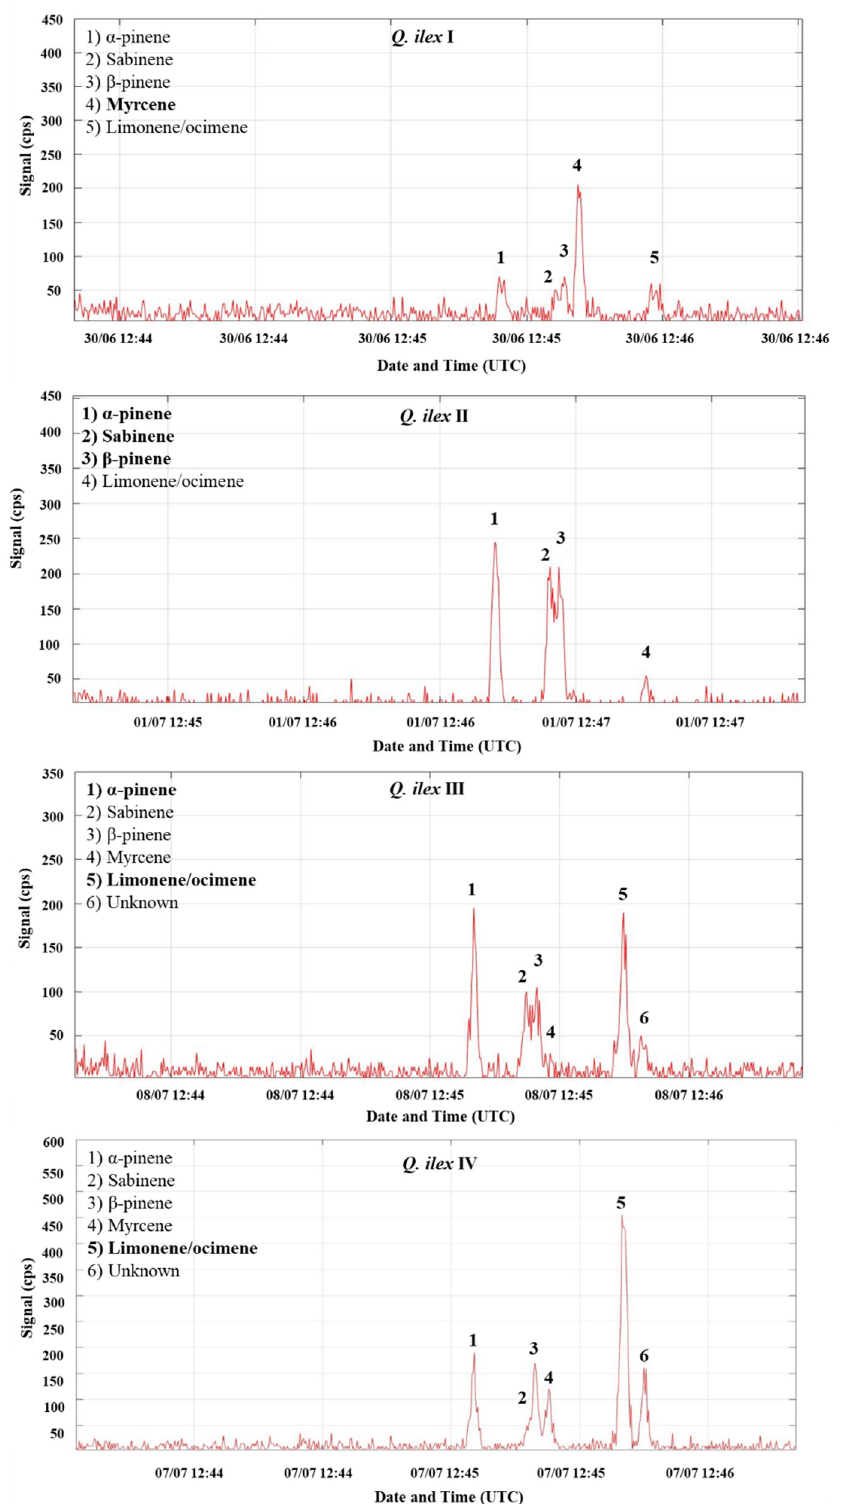
Figure 5. FastGC / PTR-MS chromatograms from the four Q. ilex branch enclosures at the same hour of Figure 5. FastGC/PTR-MS chromatograms from the four Q. ilex branch enclosures at the same hour di ff erent days (around 12:45 UTC). In bold are the dominant MTs for each of different days (around 12:45 UTC). In bold are the dominant MTs for each tree.